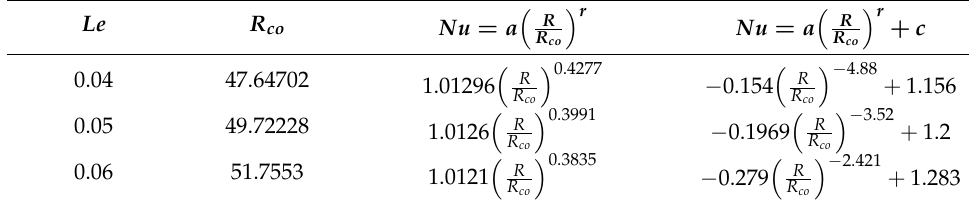
Table 2. Power law equation for different Le .